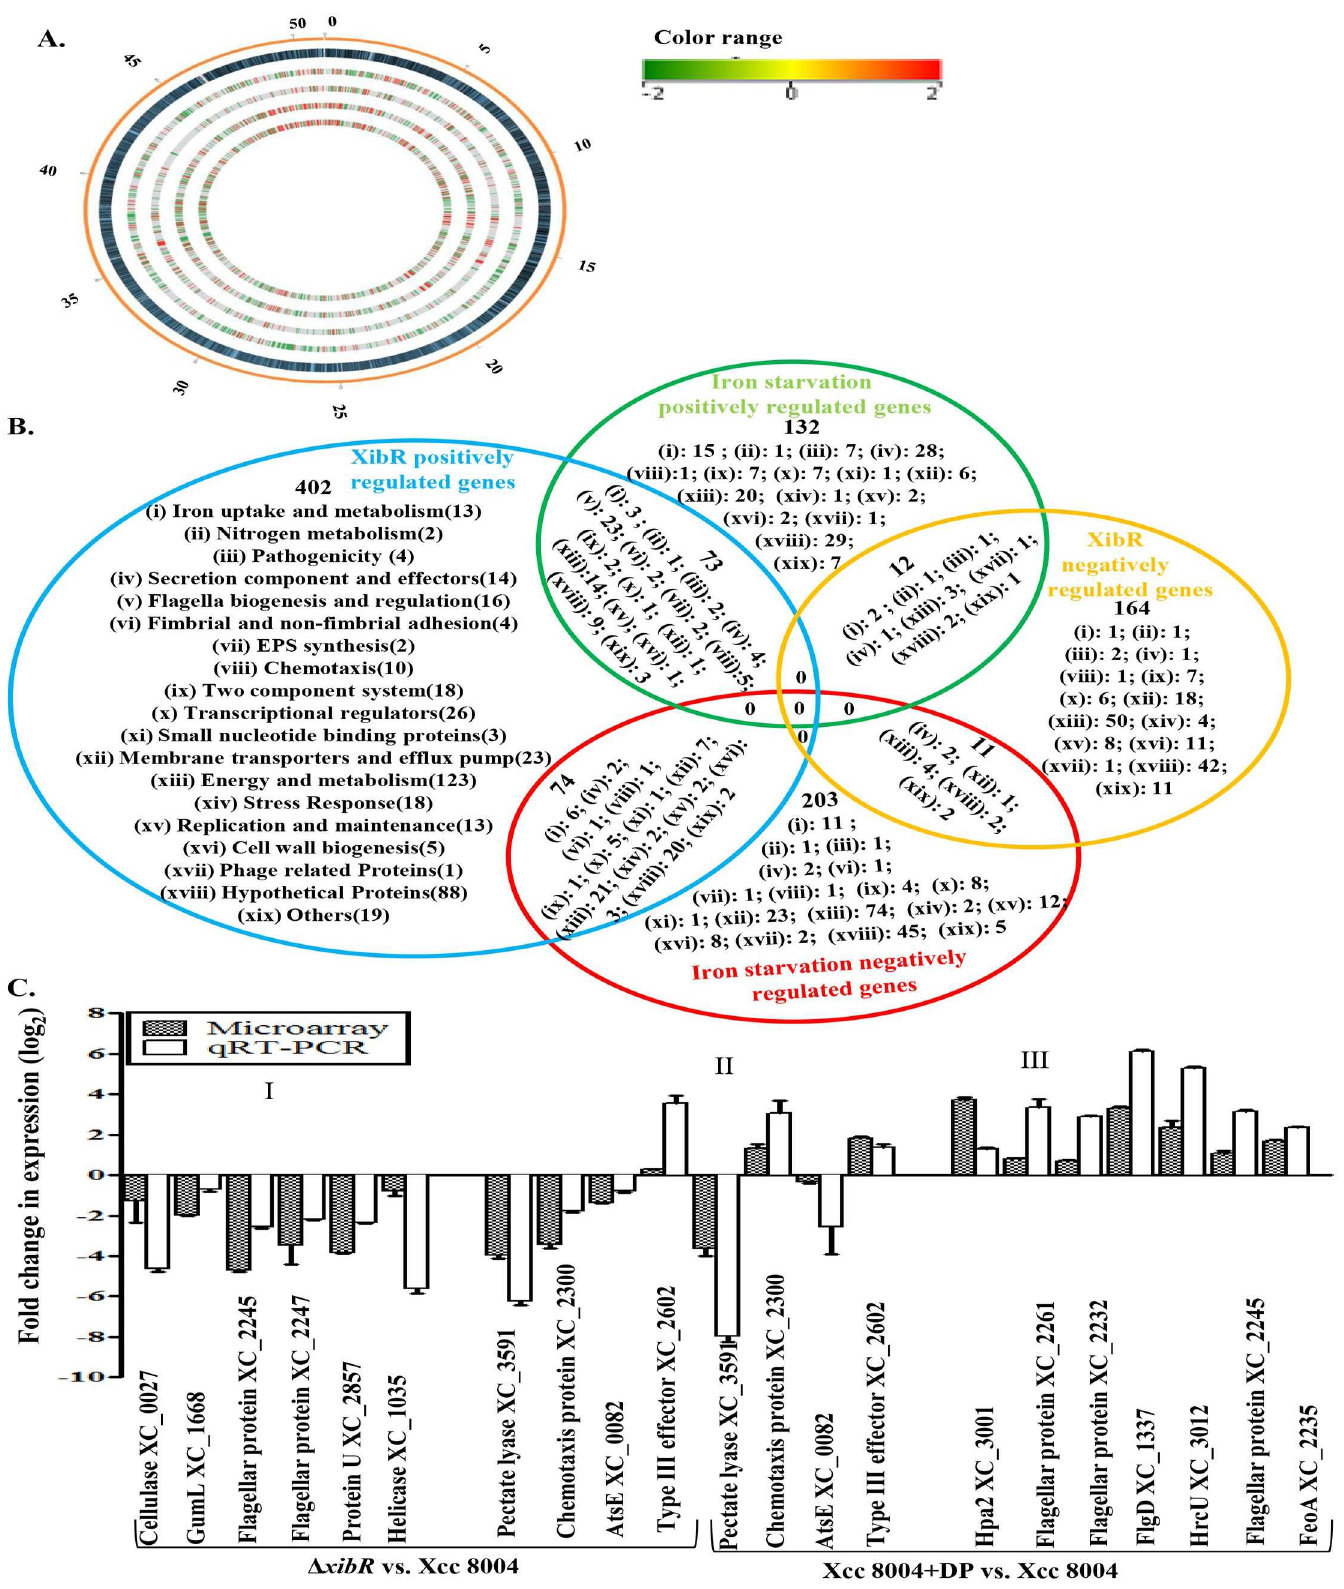
Fig 3. Genome-wide expression analysis of the iron-starvation and/or XibR regulon in Xcc. (A) The map of differentiallyexpressedgenesin response to iron limitation and/or xibR mutation in Xcc representedby using circos plot. From the outer to the inner circle, Track 1 shows circular genomeof Xcc 8004